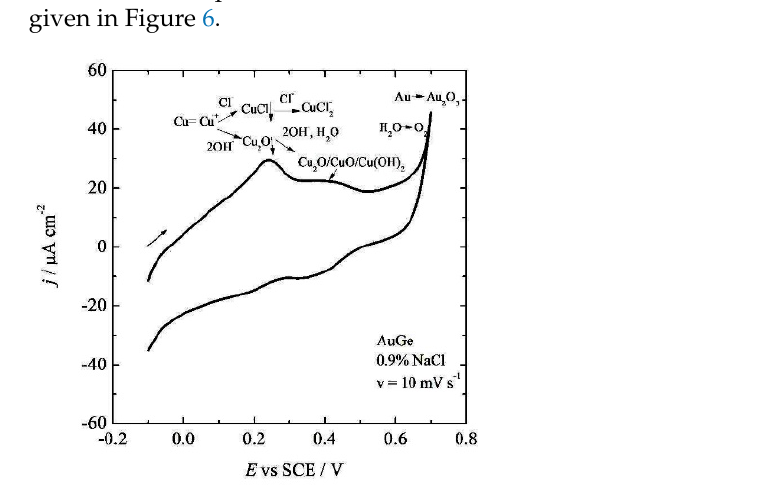
Figure 6. Cyclic voltammogram ( v = 10 mV s − 1 ) of the AuCuZnGe alloy with indicated plausible anodic reactions.